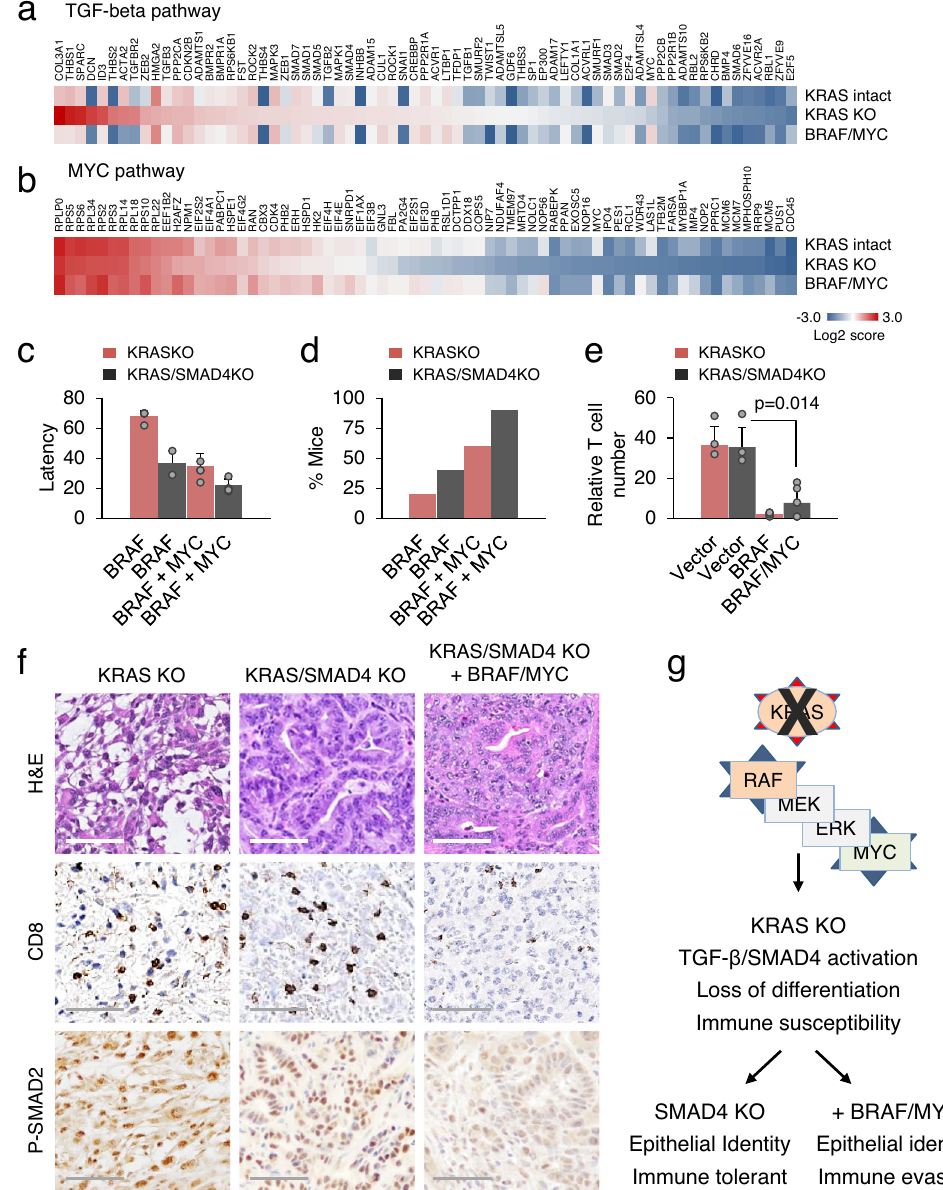
Fig. 7 MYC and SMAD4 play opposing roles in pancreatic tumor maintenance. a , b Heatmaps from scRNA-seq showing differentially expressed TGF-beta/ SMAD and MYC pathway genes in KRAS intact, KRAS KO, and BRAF/MYC reconstituted KPC tumors. c , d The mean latency ( c ) and ef fi ciency ( d ) of orthotopic tumor development in wild-type mice by KRAS KO and KRAS/SMAD4 KO KPC cells ( n = 5 for each genotype) transduced with the indicated genes. Data are presented as mean±SD, two-tailed t -test. e , f Histology and quanti fi cation of IHC staining of tumors ( n = 5 for each genotype). Data are expressed as mean±SD. Signi fi cance was determined using two-tailed test at the 0.05 con fi dence interval. Scale bar 200 μ M. g Conceptual schematic of phenotypic changes in PDAC tumors. BRAF and MYC are key mediators of KRAS-induced immune evasion. Loss of SMAD4 enhances KRAS-independent tumor